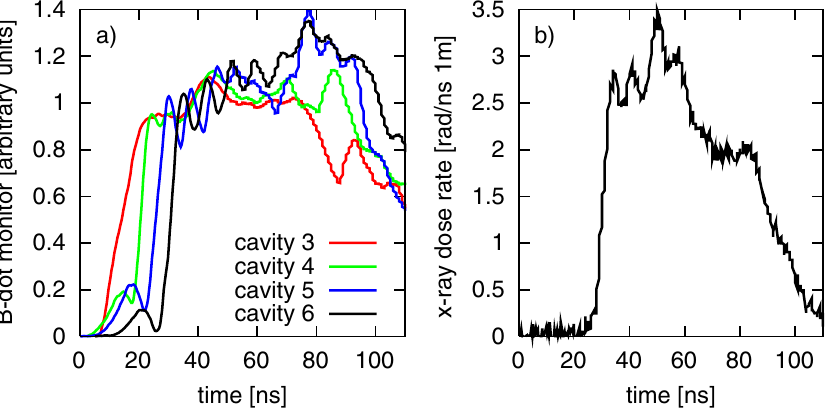
FIG. 2. (Color) Data demonstrating rf oscillations (120 MHz) on RITS-6 for a nonradiographic blade diode load (shot 13). B -dot probes located in induction cavities 3–6 are shown in (a). See the schematic in Fig. 1 for the relative locations of these cavities. The B -dot monitors shown are located 180 degrees from the radial feed. The x-ray dose rate recorded using a pin diode located approximately 3 m downstream from the electron beam converter material is shown in